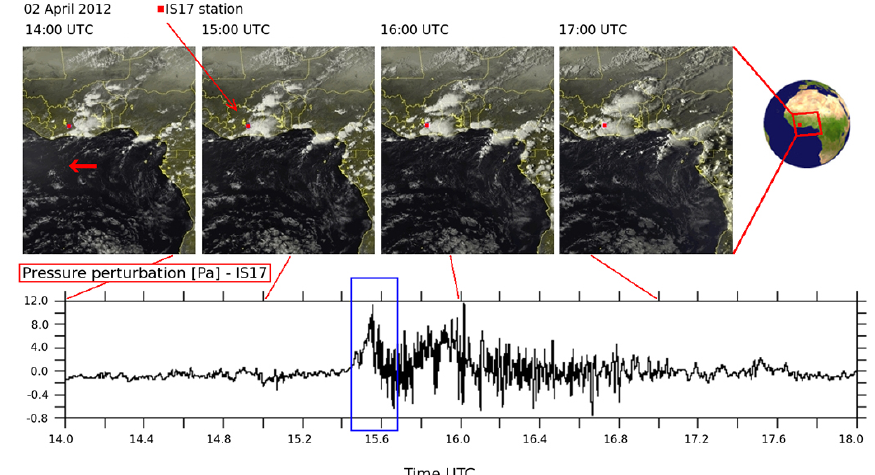
Fig. 1. Top image: true-color satellite images of West African region on 2 April 2012, at 14:00, 15:00, 16:00 and 17:00UTC. Data are provided by EUMETSAT and acquired by the geostationary meteorological satellite METEOSAT9. National borders are reported in yellow. The position of station IS17 (6.670 ◦ N, 4.850 ◦ W) is indicated by a red square symbol. The main direction of cloud motion is shown by the easterly red arrow. On the upper-right side of the figure, a red square indicates the area of Earth that is shown in the larger images. Bottom image: filtered surface pressure anomaly [Pa], retrieved by the microbarometer of infrasound station IS17, plotted as a function of time. Anomaly is defined as the difference between local pressure and a constant